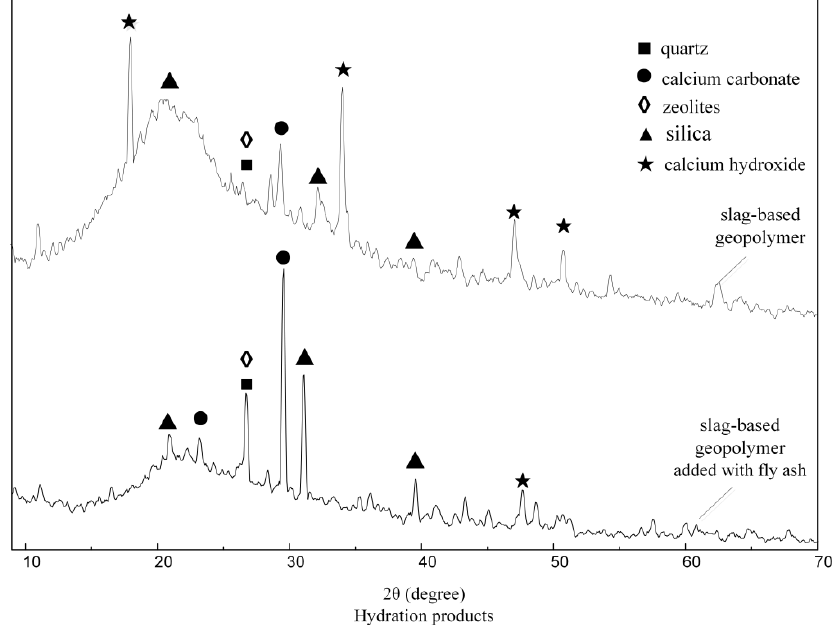
Figure 8. XRD patterns of slag-based geopolymer and slag-based geopolymer added with fly ash.